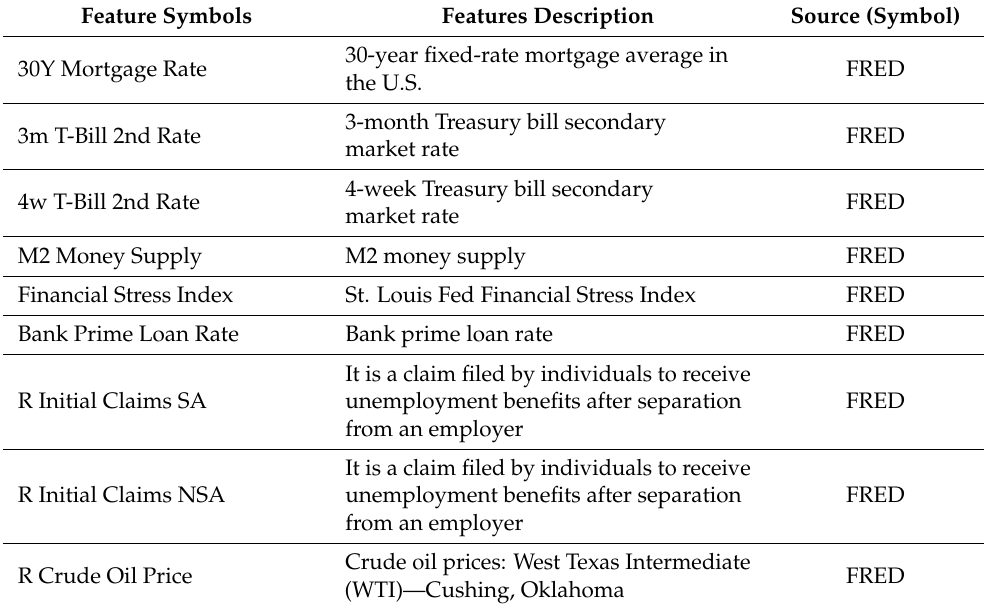
Table 2. List of additional weekly